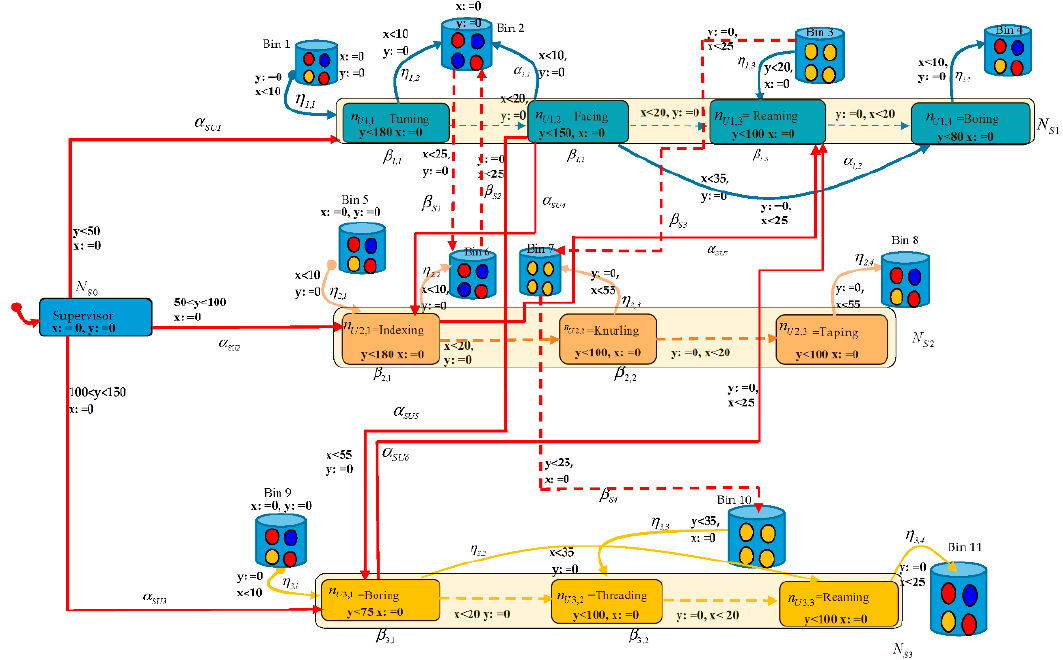
Figure 8. Supervisor